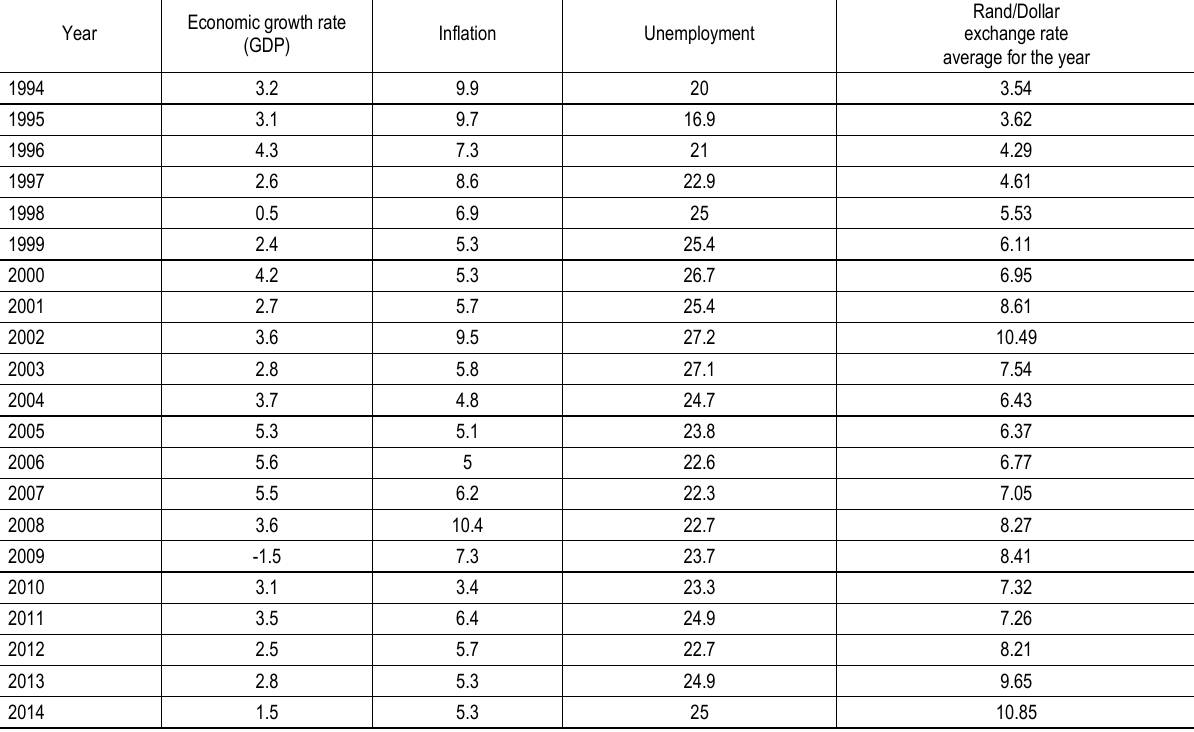
Table 1. Economic indicators of South Africa